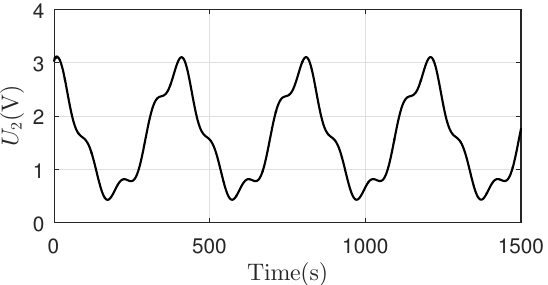
Figure 15. Control input U 2 in submerging motion with a constant velocity and variable pitch angle command.